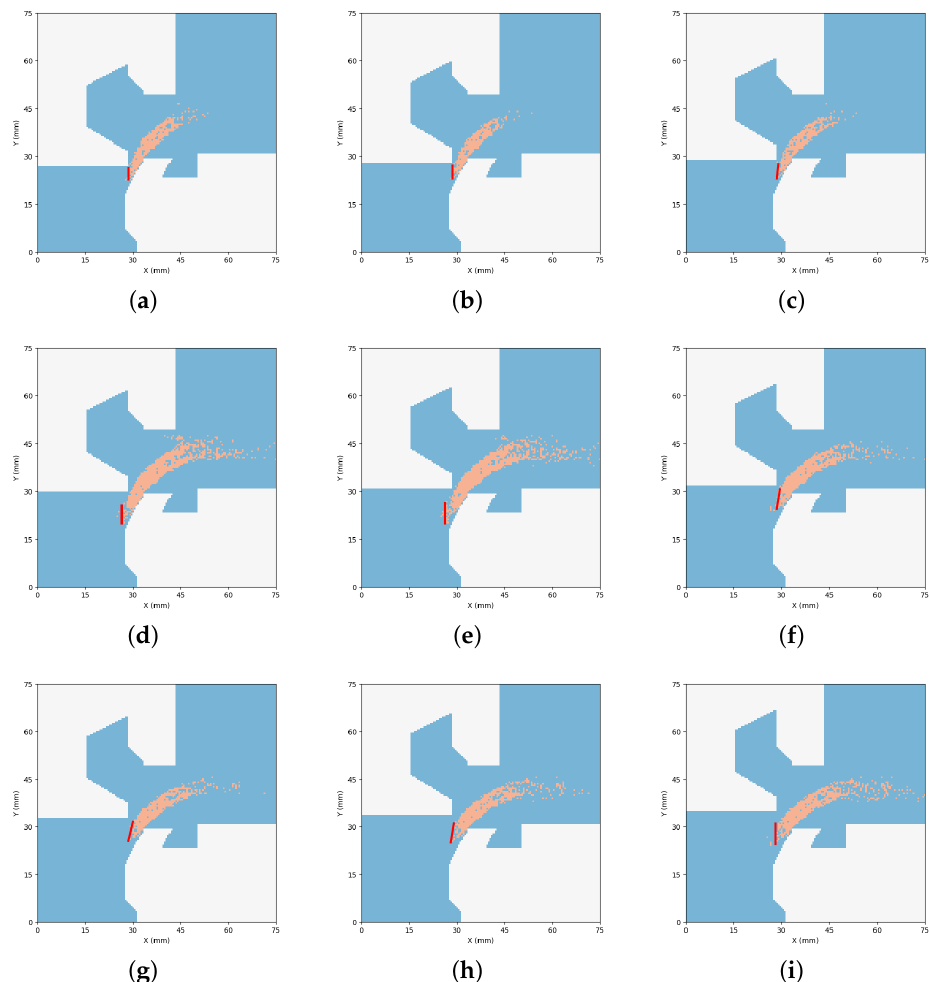
Figure 14. Extraction of location information in postprocessing reconstructed velocity field: